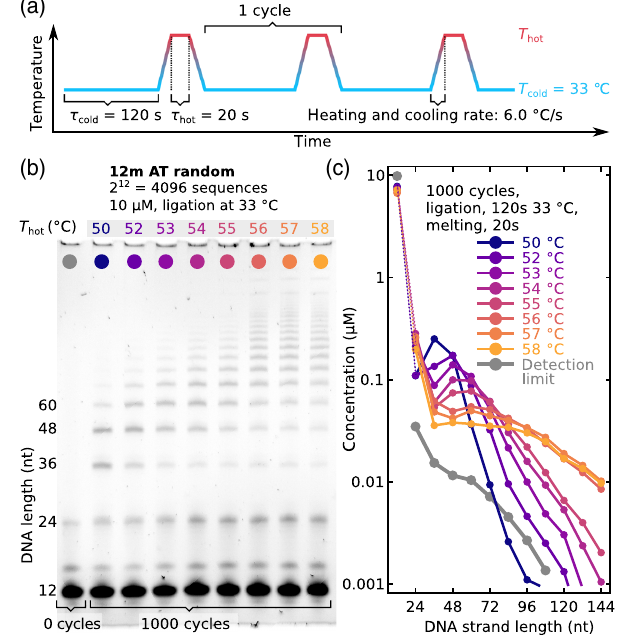
FIG. 8. Product concentration analysis for a 12 nt random sequence AT -only pool. (a) Experimental temperature profile. Ligation occurs for 120 s at 33 °C after which the sample is heated to the variable hot reassembly temperature T for 20 s. (b) Image hot of a polyacrylamide gel electrophoresis. The first lane on the left shows the “ baseline ” sample, which is similar to the other lanes but was not subjected to temperature cycling. The other lanes have the same ligation conditions but different temperatures for dissociation. (c) Quantitative results for the length distribution. Nonmonotonic length distributions with a maximum and mini- mum were